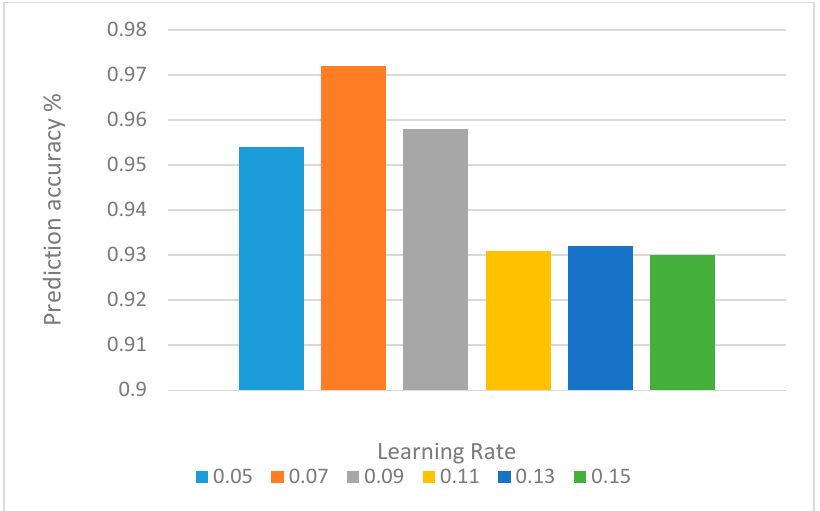
Figure 6. The impact of learning rate on performance.